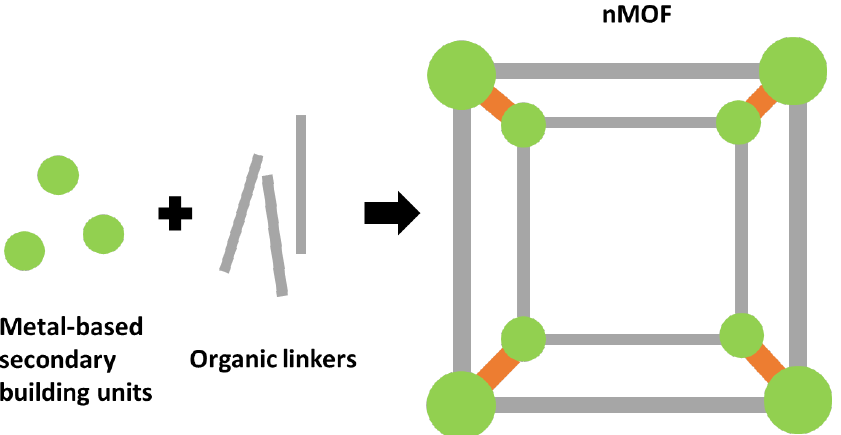
Figure 2. Schematic illustration of the construction of a nanoscale metal–organic framework (nMOF) from metal-based secondary building units and organic linkers.